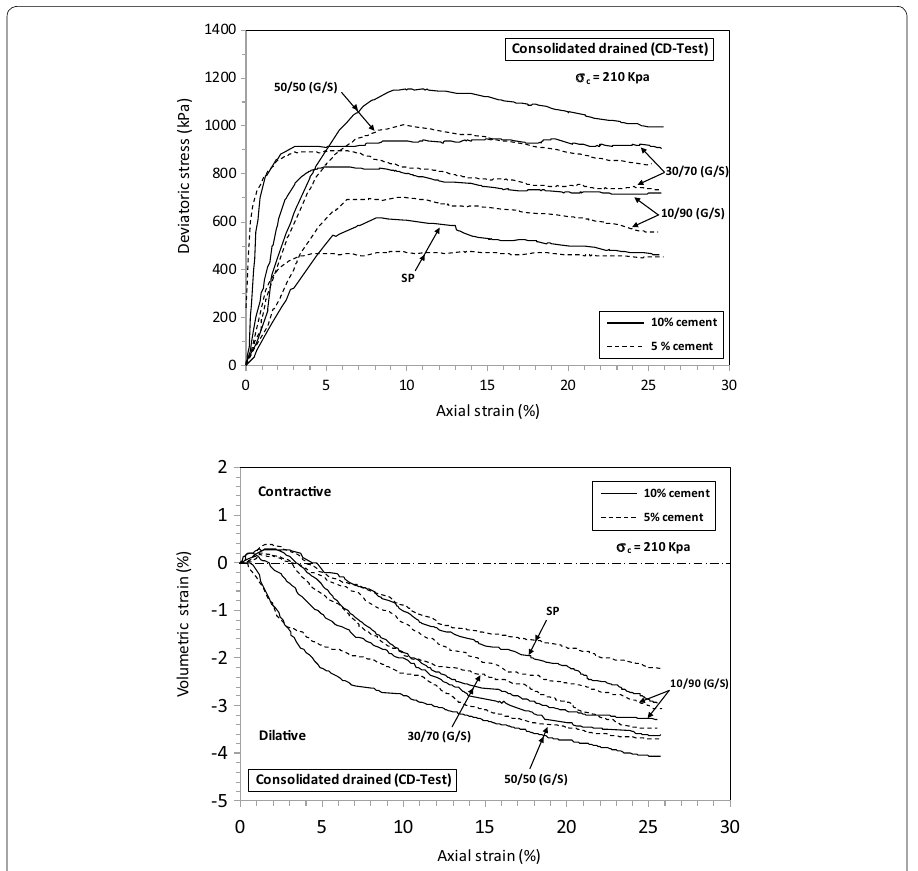
Fig. 7 CD triaxial shear test results for 5 and 7% cement stabilized SP and CG–SP